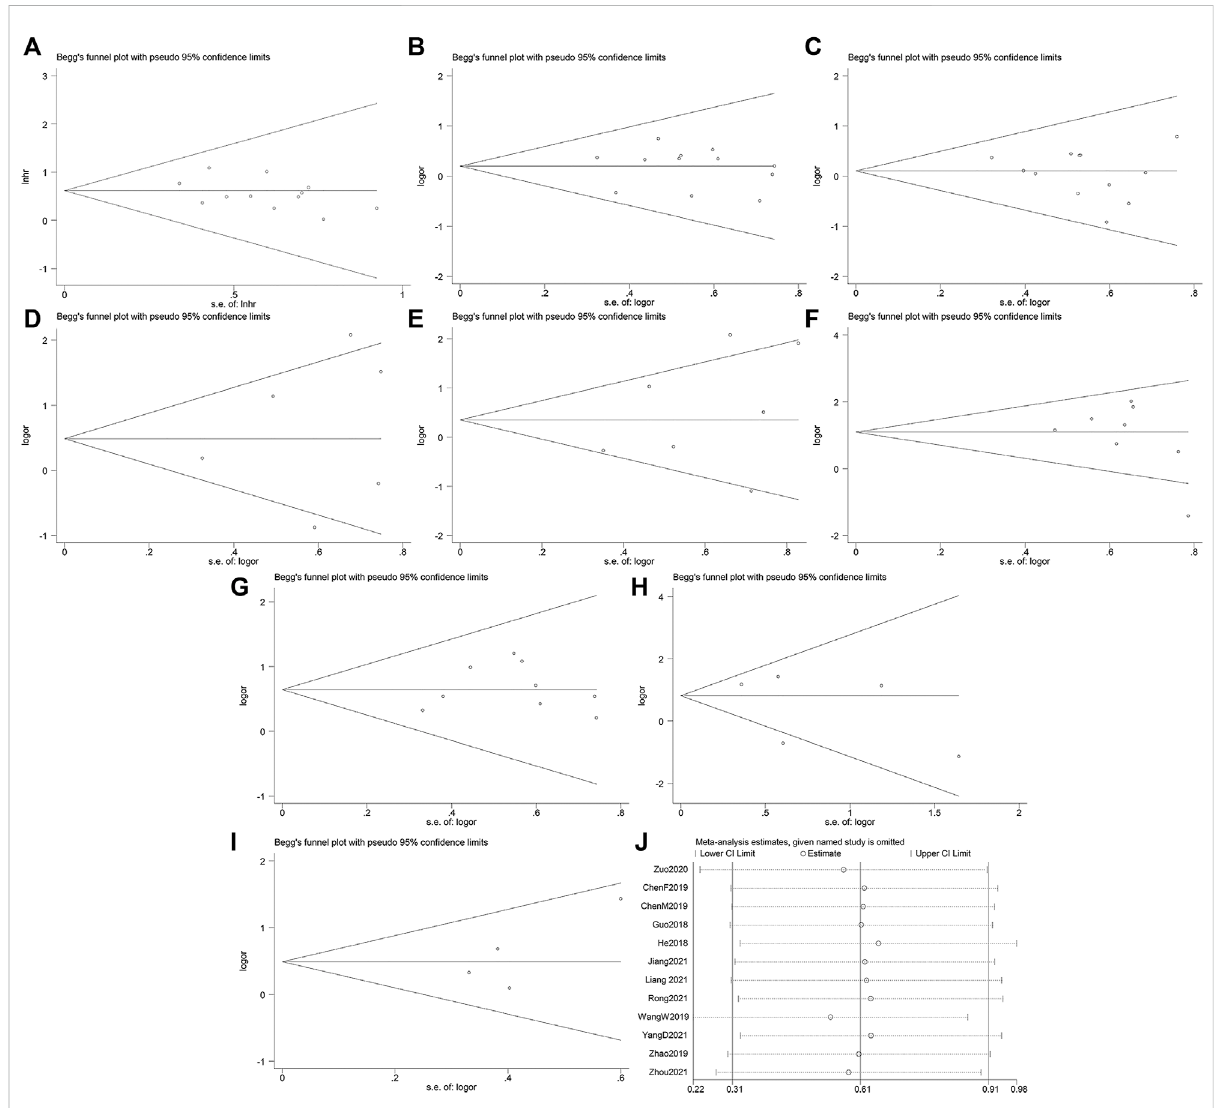
FIGURE 4 Begg ’ s funnel plots and sensitivity analysis. (A) Begg ’ s funnel plot for OS. (B) Begg ’ s funnel plot for age. (C) Begg ’ s funnel plot for sex. (D) Begg ’ s funnel plot for differentiation. (E) Begg ’ s funnel plot for tumor size. (F) Begg ’ s funnel plot for the TNM stage. (G) Begg ’ s funnel plot for lymph node metastasis. (H) Begg ’ s funnel plot for distant metastasis. (I) Begg ’ s funnel plot for degree of in fi ltration. (J) Sensitivity analysis for studies about